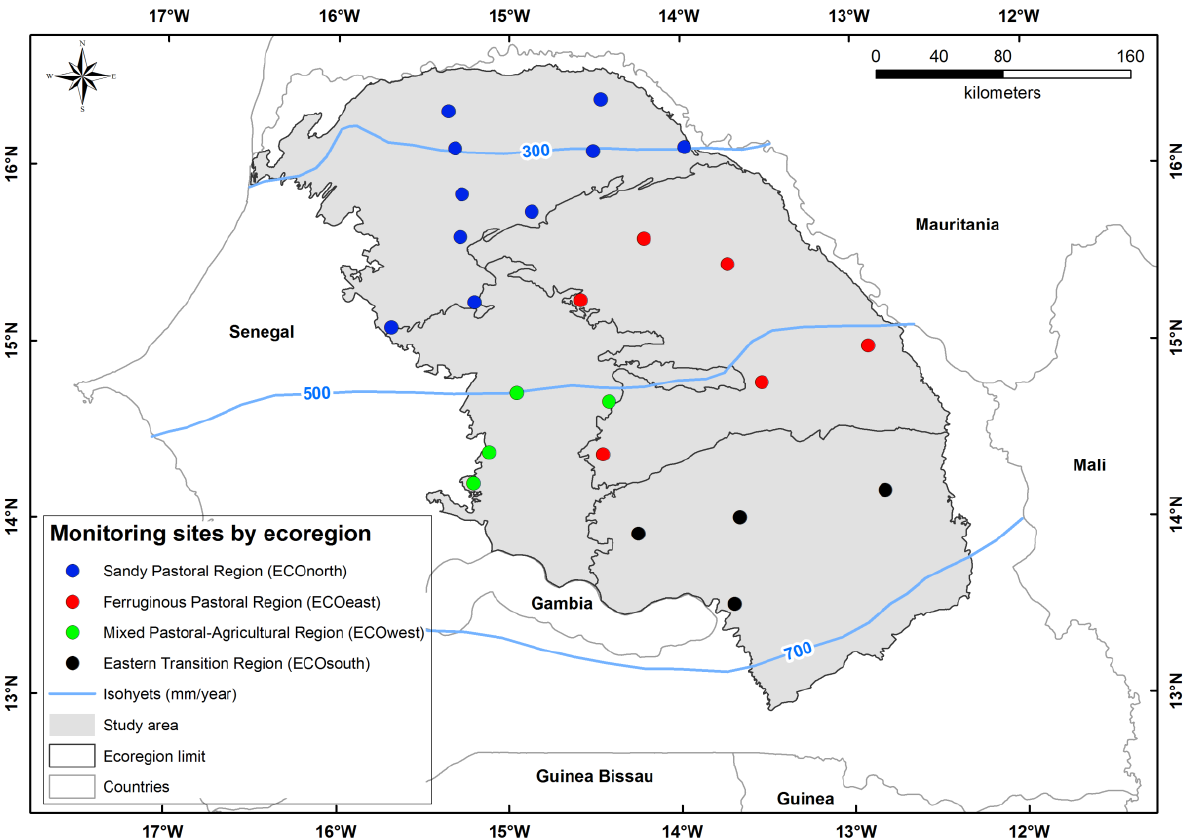
Figure 1. Location of monitoring sites in the study area covering a range of Sahelian ecosystems in Senegal. The isohyets are based on average rainfall estimates provided by FEWS Net between 1999 and